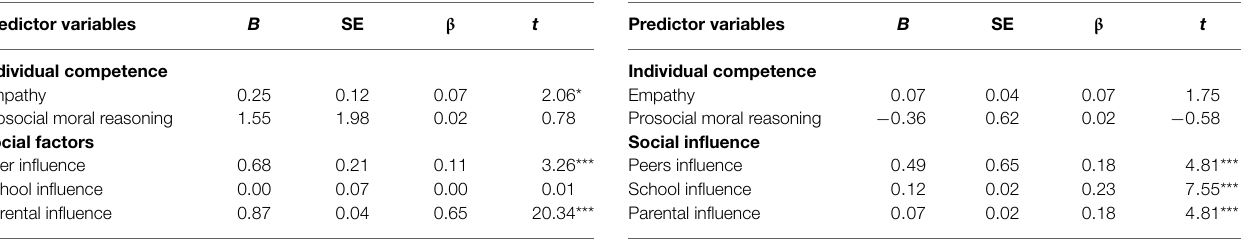
TABLE 3 | Prediction of helping intention from individual competence and social influence factors ( N = 549) .